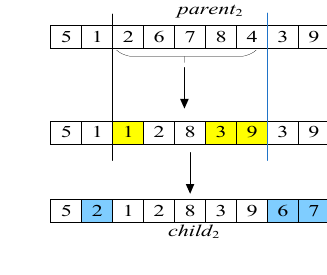
Figure 4. LOX process.